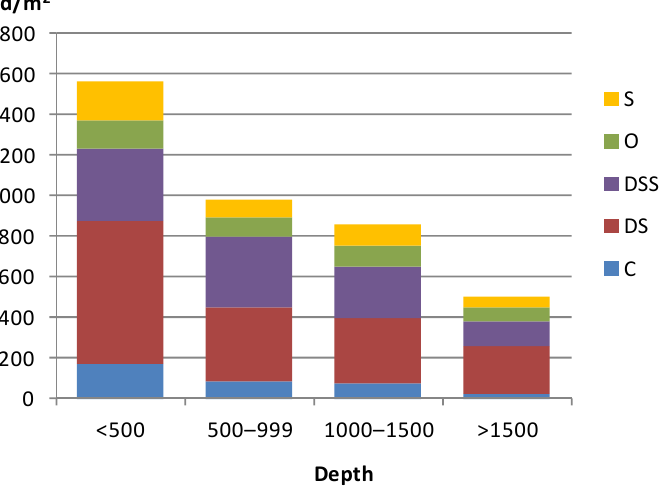
Figure 6. Relative abundance (%) of macrofaunal feeding types at each strata. O: Others group; C: carnivores; S: suspensivores; DSS: subsurface deposit feeders; DS: surface deposit feeders.